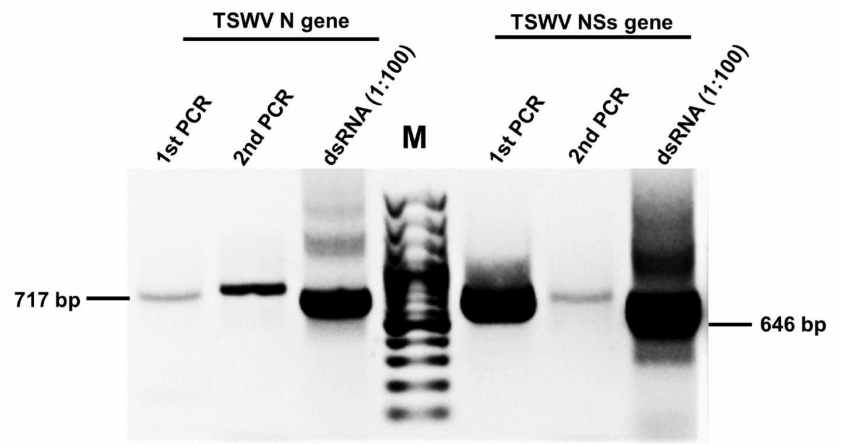
Figure 1. Production of dsRNA molecules specific to the tomato spotted wilt virus nucleocapsid (N) gene and non-structural (NSs) genes by two-step PCR method and in vitro transcription. M: 100 bp DNA ladder.